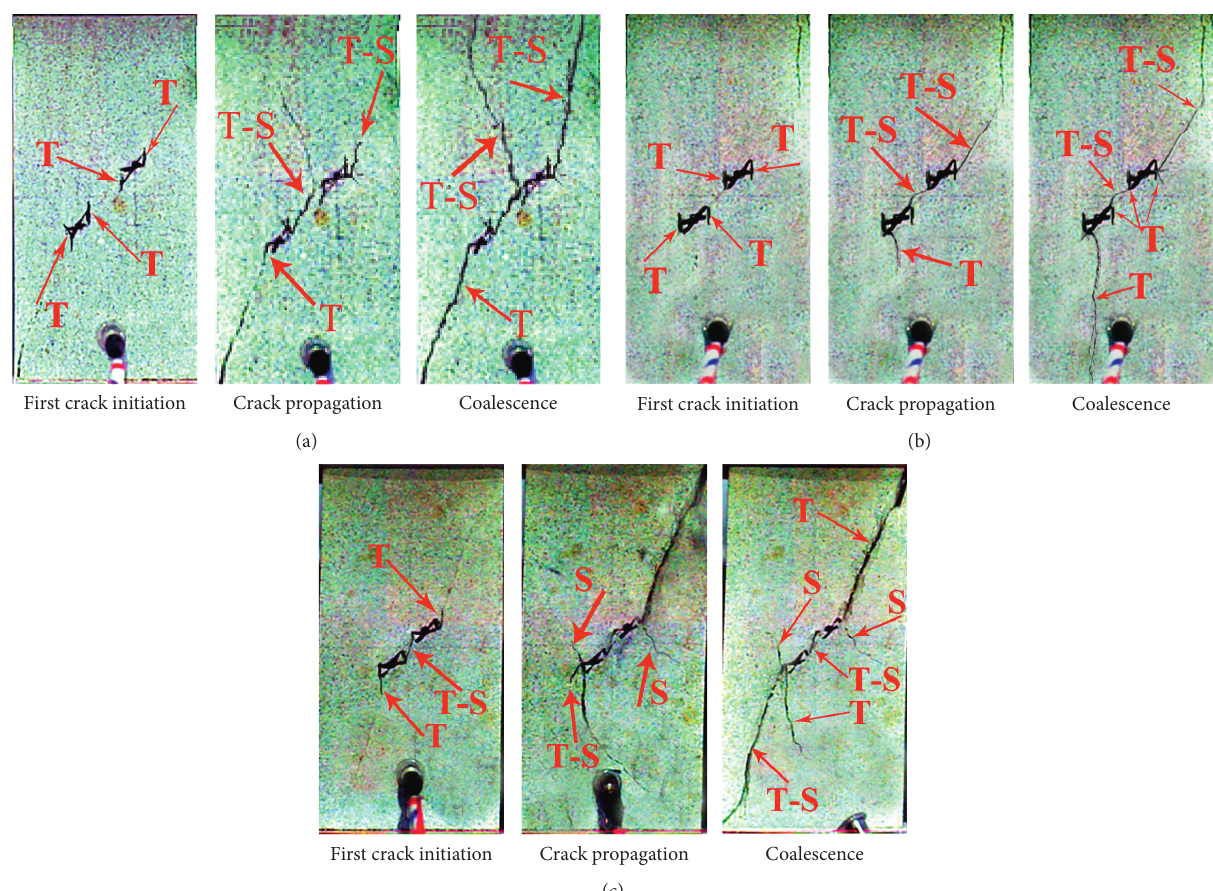
Figure 6: Crack evolution diagram for three joint continuity parameters: (a) k � 0.57, (b) k � 0.67, and (c) k �